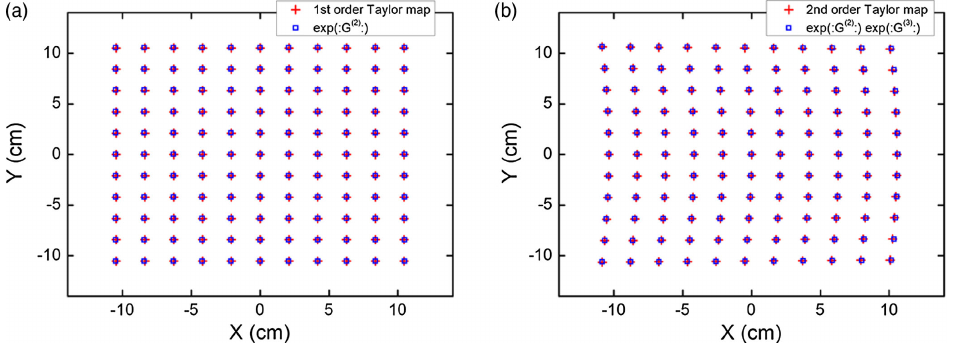
FIG. 12. Single-particle distributions at the isocenter for different scanning angles with 15-mrad interval for both transverse planes, from 0 to 50 mrad. Tracking results are drawn for first-order Taylor map and corresponding Lie map, exp ð ∶ G ð 2 Þ ∶ Þ (a), and second-order Taylor map and corresponding Lie map, exp ð ∶ G ð 2 Þ ∶ Þ exp ð ∶ G ð 3 Þ ∶ Þ